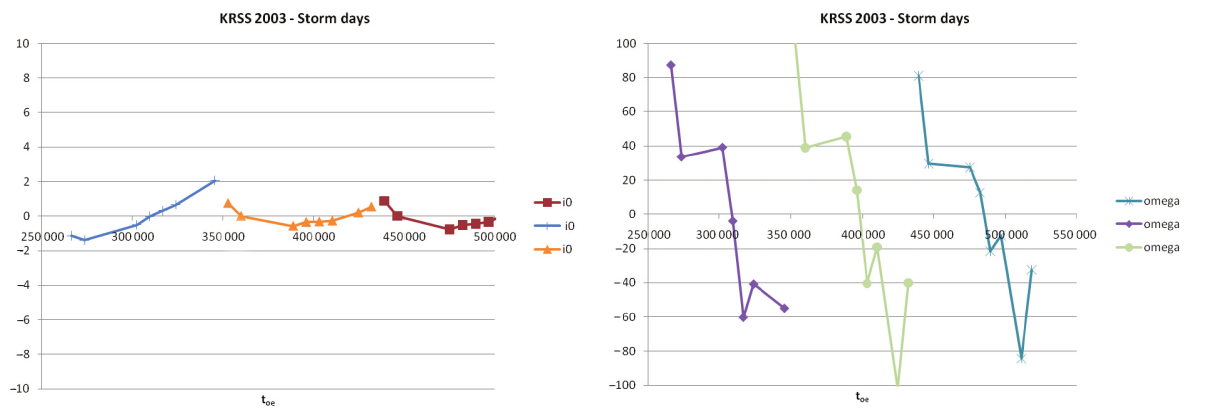
Fig. 2. Inclination for three stormy days in 2003 using cPOS stations (KRSS)